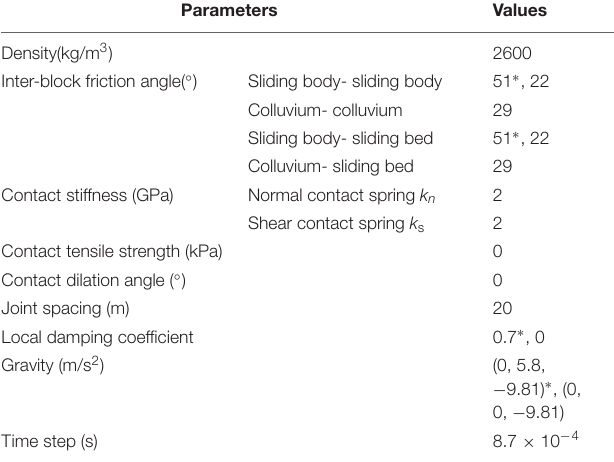
TABLE 1 | Input parameters in